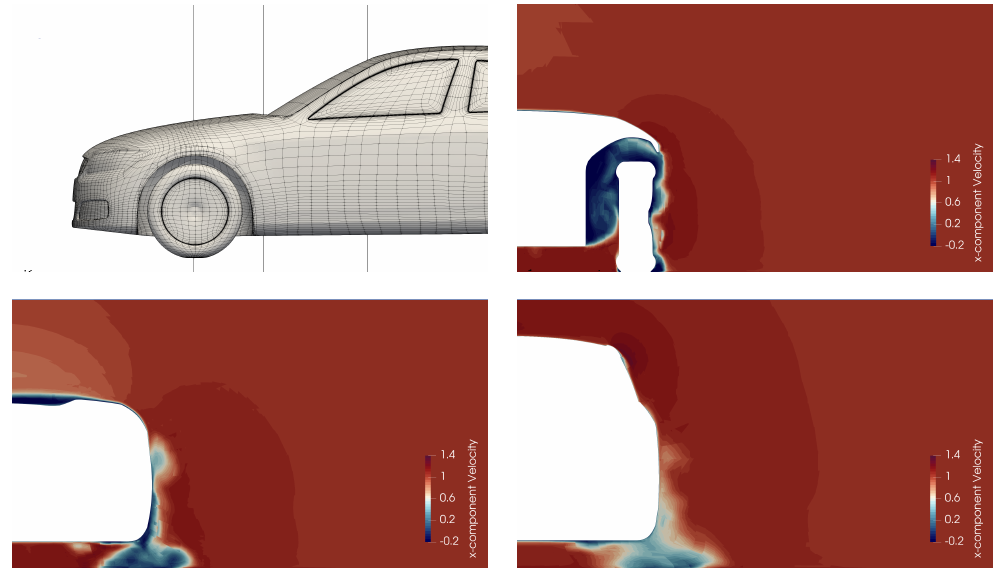
Figure 17. DrivAer model ( top , left )—Time-averaged x -velocity contours at different slices: x / L = 0.173 ( top , right ), x / L = 0.273 ( bottom , left ), and x / L = 0.423 ( bottom , right ).